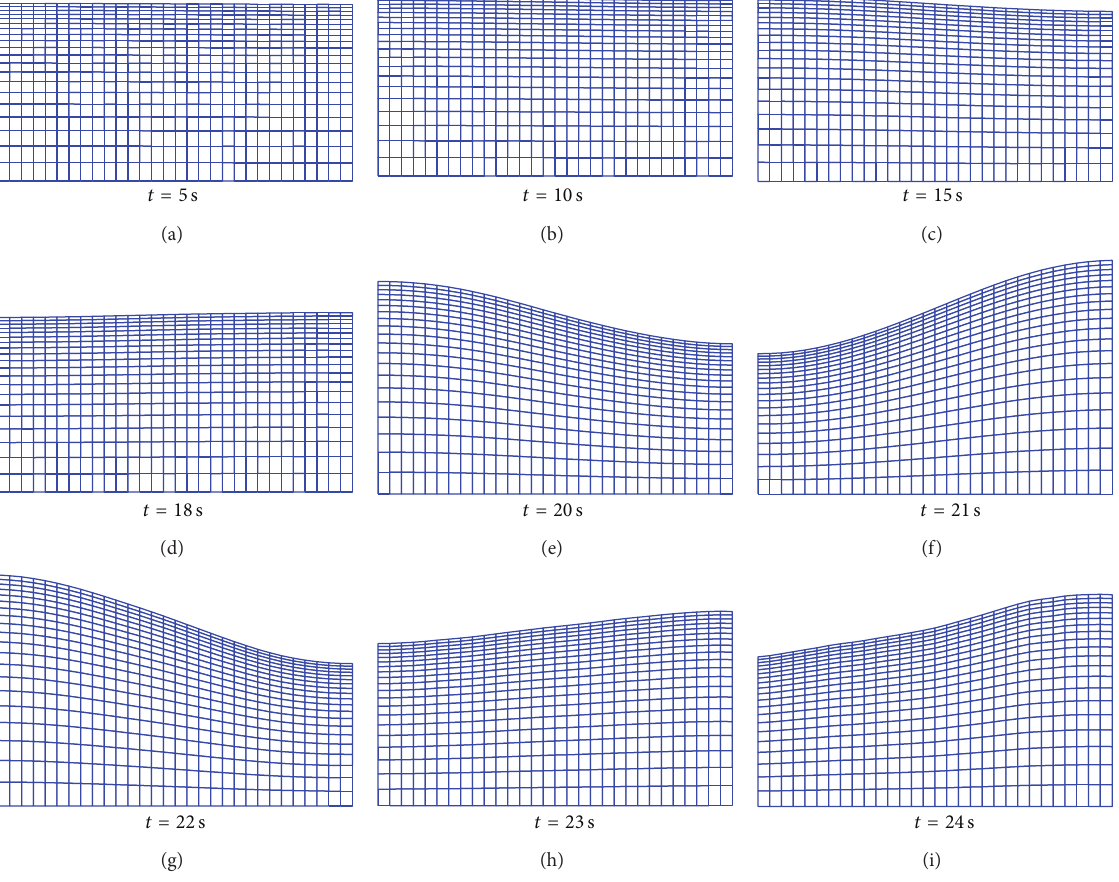
Figure 7: Moving mesh generated at different type steps in parametric